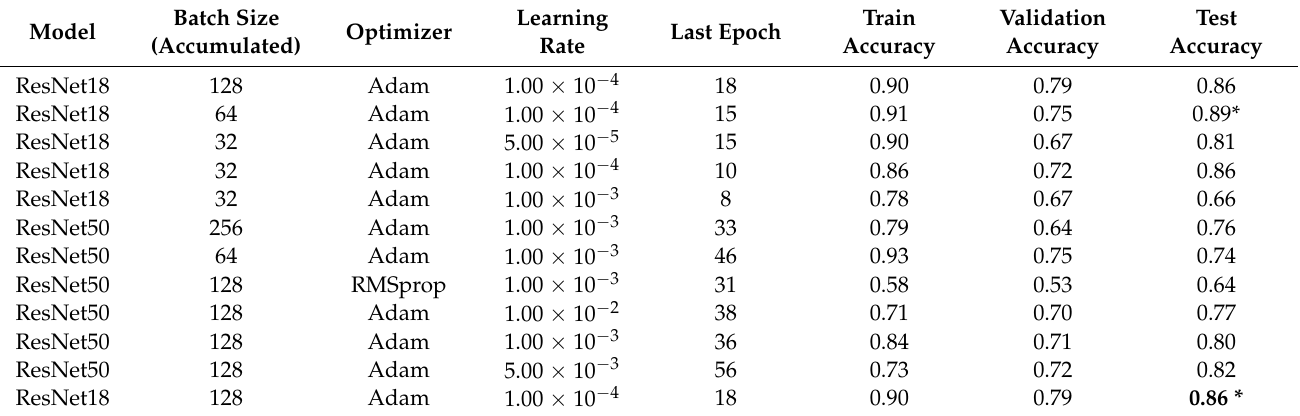
Table 6. Training hyperparameters and performance for models trained on the thin-section data when the model starts with randomly initialized